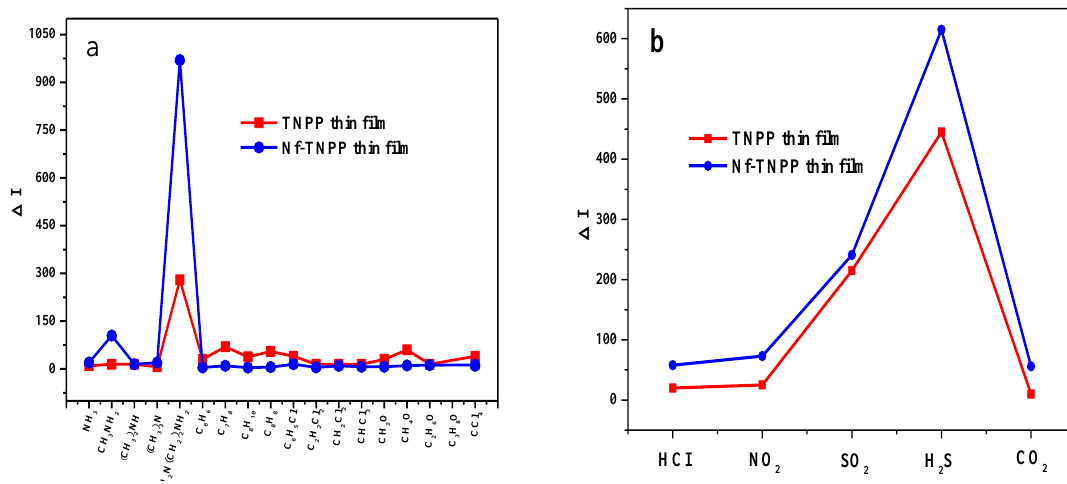
Figure 1. Responses of tetrakis(4-nitrophenyl)porphyrin (TNPP) and Nafion membrane (Nf)-TNPP thin film/K + -exchanged OWG sesnors upon exposure to ( a ) VOCs and ( b ) inorganic gases at room temperature (gas concentrations: 100 ppm).